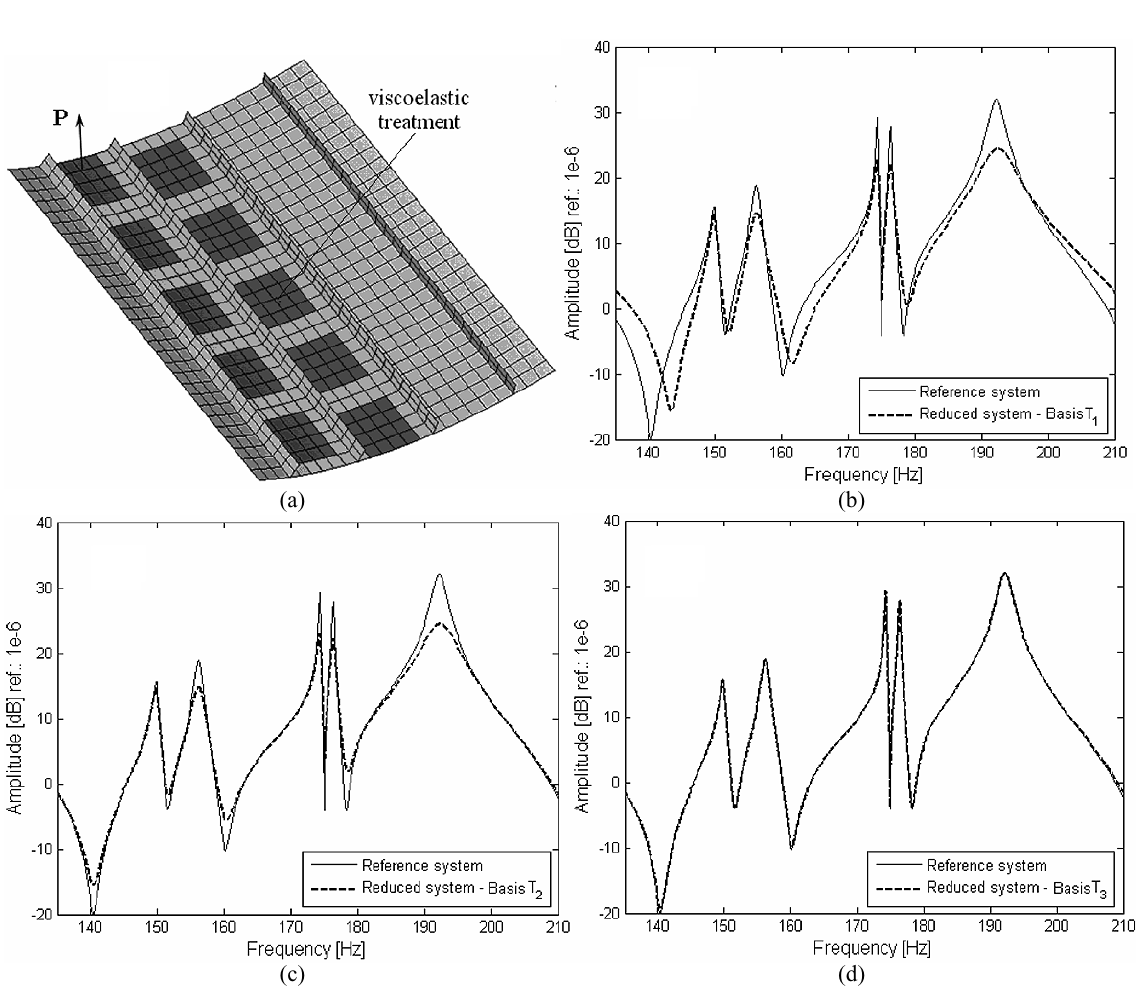
Fig. 7. (a) FE model of the stiffened panel treated with PCLD; FRF amplitudes of the reference and reduced systems by using the basis (b) T 1 , (c) T 2 and (d) T 3